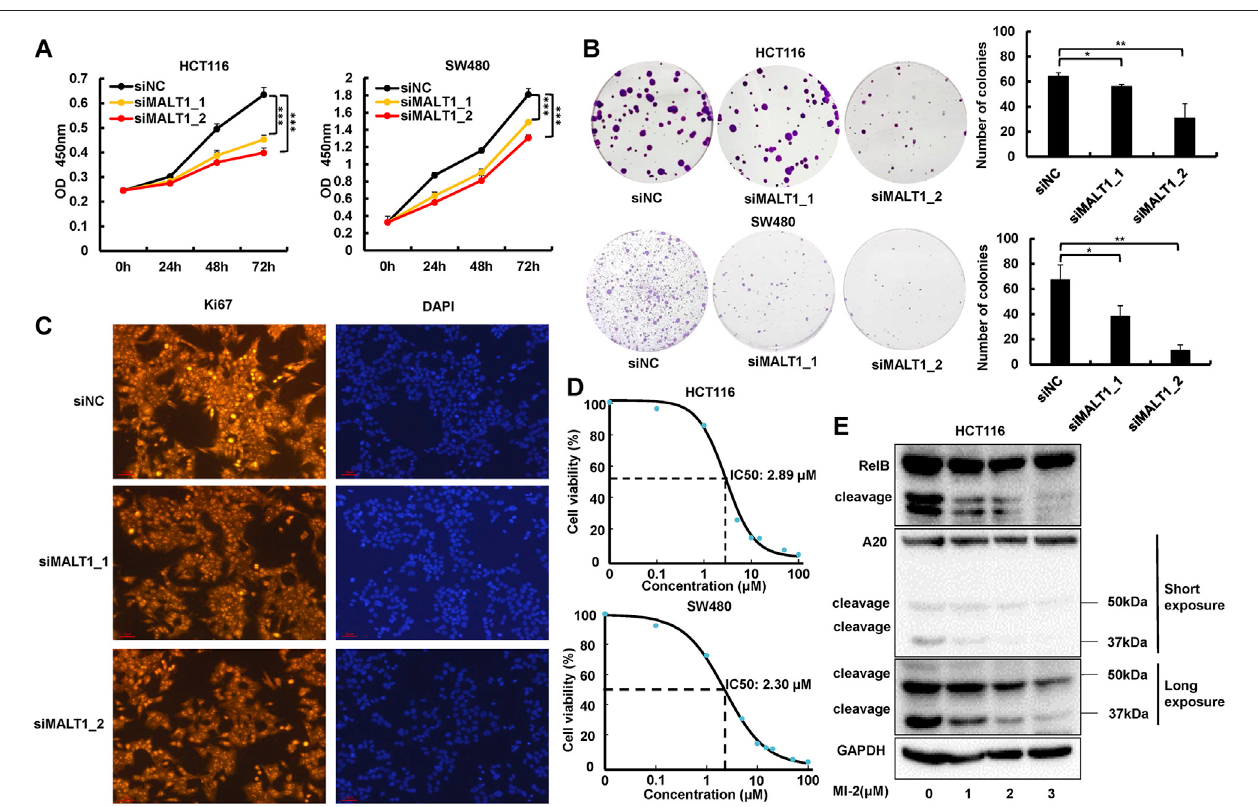
FIGURE 2 | Inhibition of MALT1 reduced CRC cell proliferation. (A) Cell proliferation of CRC cells was determined by CCK-8 assays at 24, 48, and 72 h after transfection,asdescribed. (B) ColonyformationwasassessedbycrystalvioletstaininginCRCcellsaftertransfection. (C) ProliferationindicatorKi67wasdeterminedby immuno fl uorescence (IF) staining in HCT116 cell. (D) IC 50 of MI-2 in HCT116 and SW480 cells was detected by CCK-8 assays. (E) MALT1 cleavage of RelB and A20 inhibition by MI-2 in HCT116 cells determined by immunoblotting. Each experiment was performed in triplicate, and data are presented as mean ± SD. One-way ANOVA and Dunnett ’ s multiple comparison test were used to analyze the data (* p < 0.05, ** p < 0.01, *** p < 0.001).